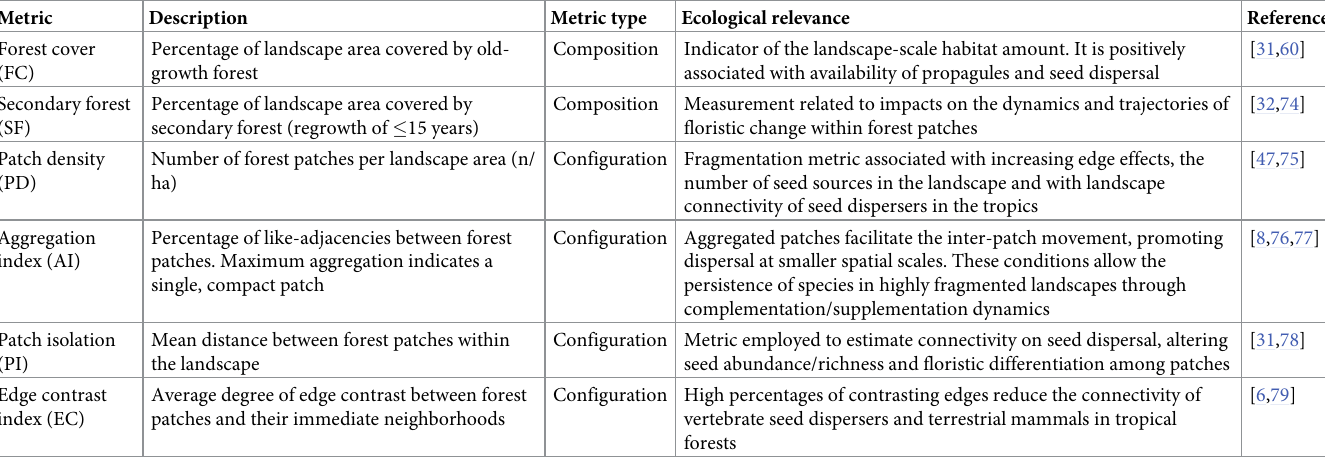
Table 1. Description, metric type and ecological relevance of the landscape metrics measured at class level employed in the